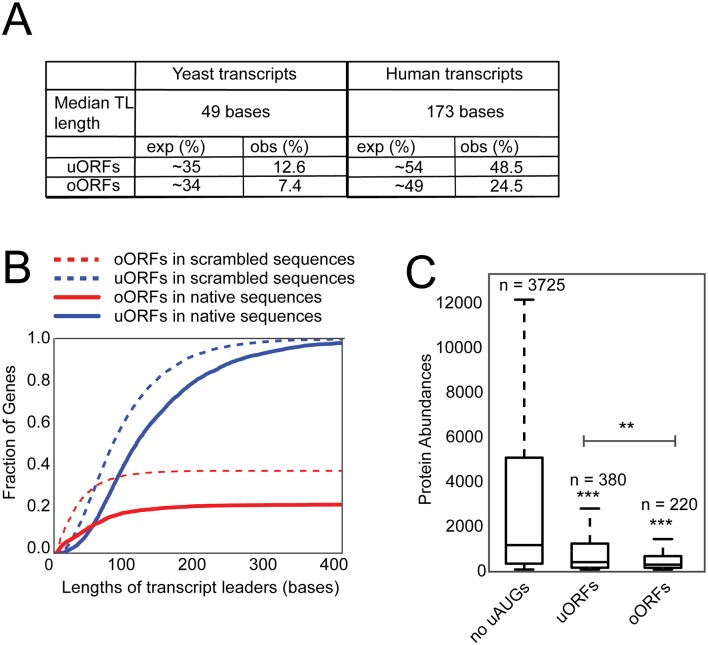
oORFs are more selected against than uORFs.A) The percentage of protein coding genes in yeast and human cells that contain uORFs or oORFs. The expected fraction was calculated from a single randomization of each TL. Several independent randomizations were performed with very similar results. B) The relationship between transcript leader lengths and observed and expected numbers of uORFs (3 reading frames) and oORFs (2 reading frames) in yeast URSs C) Box plots indicating the relationship between protein abundance, uORFs and oORFs for yeast genes. Genes were grouped into those with uORFs, or ORFs, for simplicity genes with both are not plotted. Protein abundance measurements are taken from [31]. The box indicates 25th and 75th percentiles, with the difference between these two being the interquartile range (IQR). The upper whisker represents the largest data point less than 1.5 x IQR. Similarly, the lower whisker represents the smallest data point greater than 1.5 x IQR. Any data points outside of this range are considered to be outliers and not indicated. P values are calculated using an unpaired t-test. (**) P < 0.01 (***) P < 0.001.